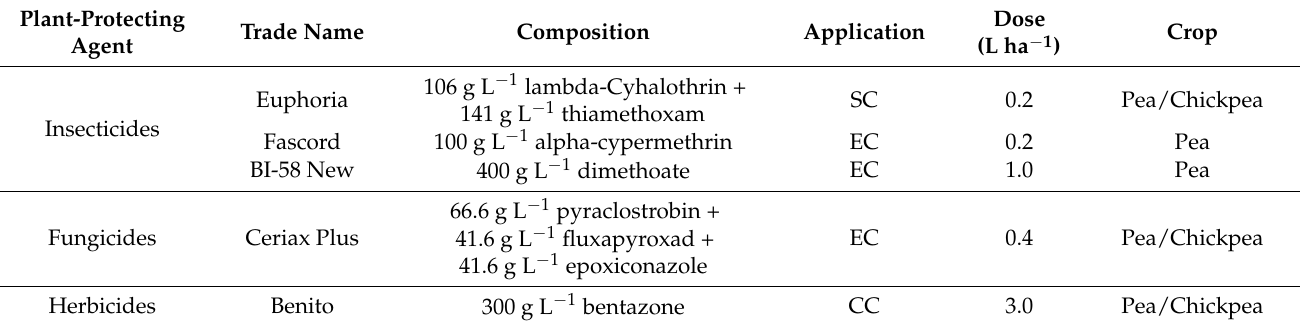
Table 1. Chemical plant protection products used in this